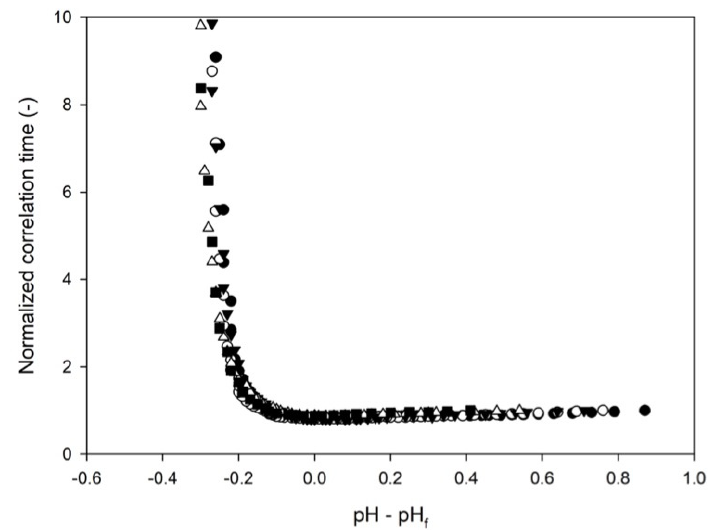
Figure 4. DWS traces of reconstituted skim milk (100 g L − 1 milk solids) containing 0 (- ● -), 2 (- ○ -), 4 (- ▼ -), 6 (- ▽ -), 8 (- █ -) or 10 (- □ -) % ethanol as a function of pH-pH f during incubation with 25 g L − 1 GDL at 32 ◦ C. Values are means of experiments on three individual milk samples. The coefficient of variation was less than 5% for all data points.